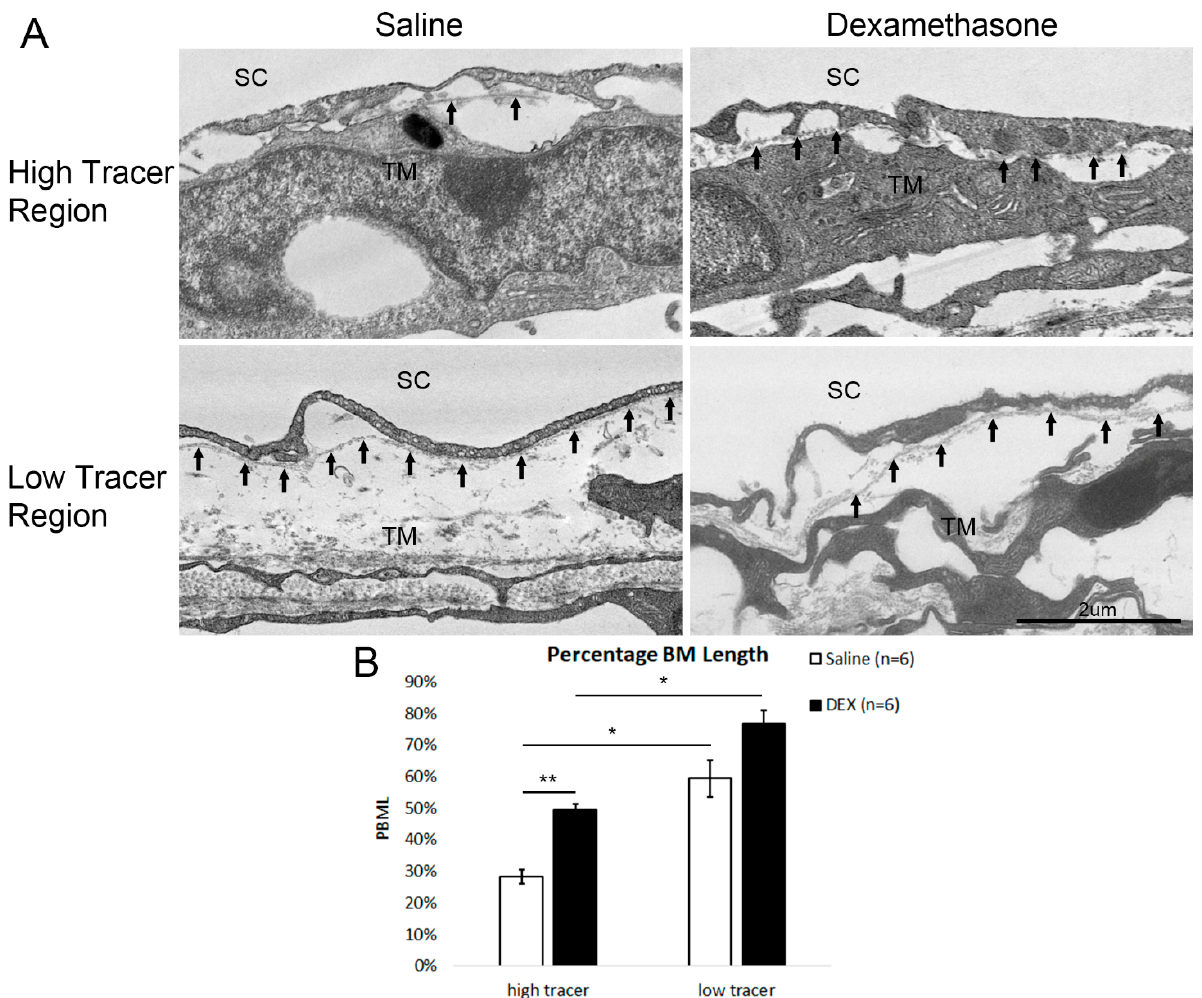
Figure 8. Increased PBML after DEX Treatment by Electron Microscopy. ( A ) Representative electron microscope images around the inner wall of Schlemm’s canal (SC) from high- and low-tracer regions of saline- and dexamethasone (DEX)-treated eyes. Black arrows indicate the basement membrane (BM), or fibrillary BM-like structure formed after DEX treatment. ( B ) In both saline- and DEX- treated eyes, mean percentage BM length (PBML) is significantly greater in low-tracer regions compared to high-tracer regions (*: p < 0.05; **: p < 0.01). DEX treatment induced a significant increase in mean PBML in high-tracer regions compared to that in high-tracer regions in control eyes (*: p < 0.05).